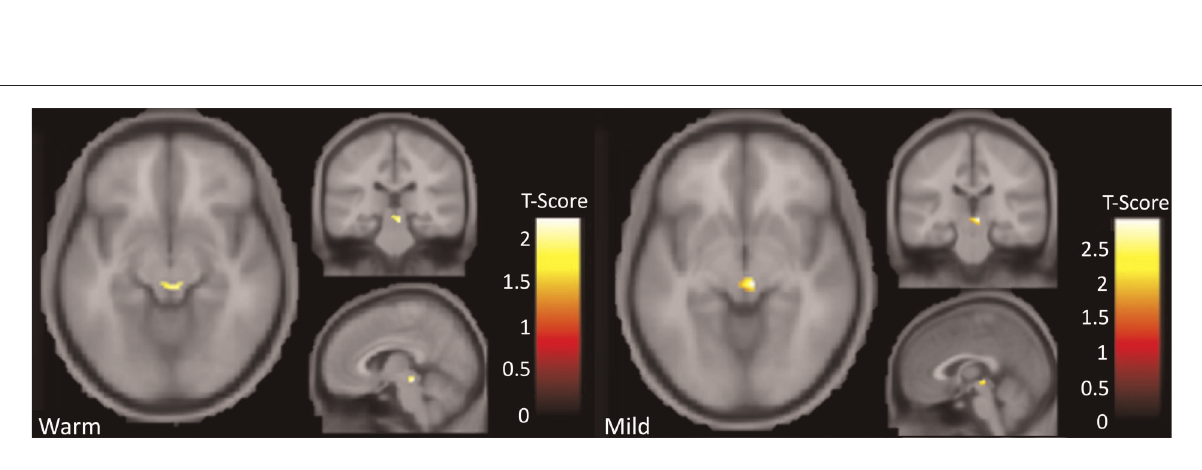
FIGURE 1 Results indicating greater activation in AD participants relative to controls in the PAG for the contrast comparison of warmth greater than pre- stimulus (left) and mild pain greater than baseline